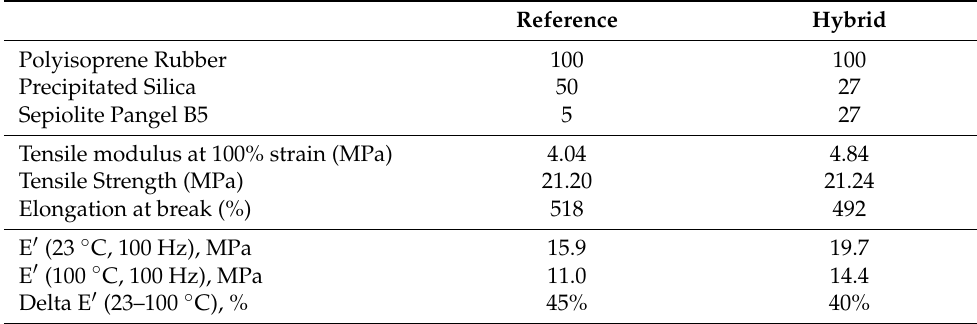
Table 2. Properties of tire base compound taken from ref. [41].